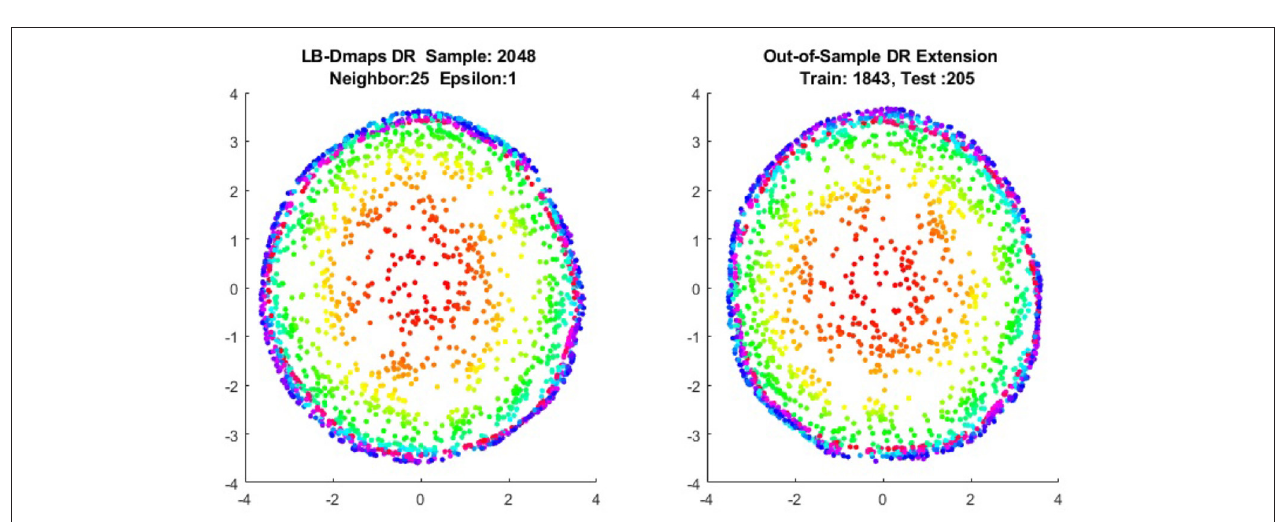
FIGURE 7 | LB out-of-sample extension for DR of Punched